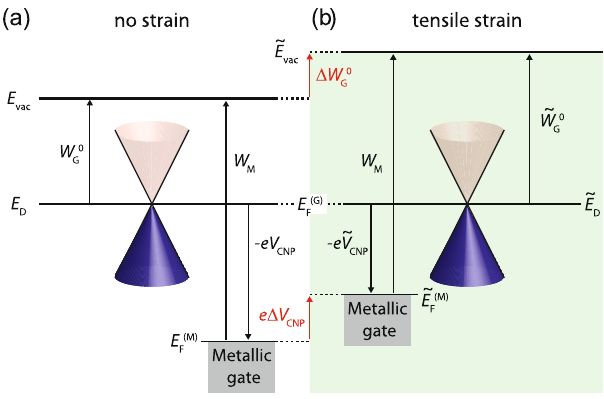
Fig. 4 Schematic energy level diagram. a Energy level diagram of the device at the charge neutrality point (CNP) for unstrained and b strained (green shaded) graphene. The Fermi levels of the graphene and the metallic ð M Þ gate are denoted E ð G Þ and E ð M Þ ( e E ), respectively. The work function (WF) F F F of the metallic gate is denoted W M , assumed to be a constant. In our measurements, the graphene is grounded and therefore E ð G Þ is fi xed. The F gate voltages tuning the graphene to the CNP for the unstrained and strained cases are denoted V CNP and e V CNP , respectively. The WF difference of undoped graphene between with and without strain is denoted Δ W 0 . G